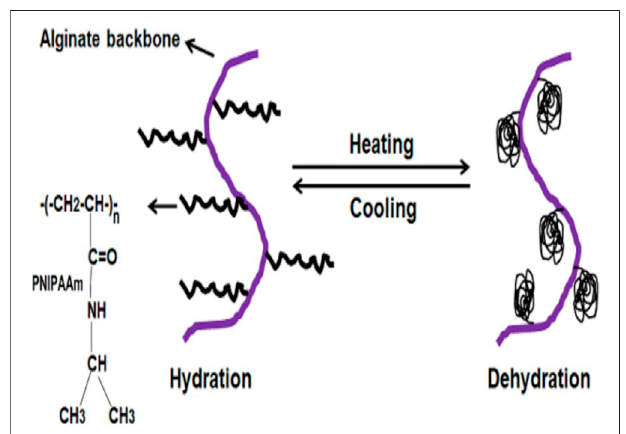
FIGURE 6 | Thermal gelation process in a protein